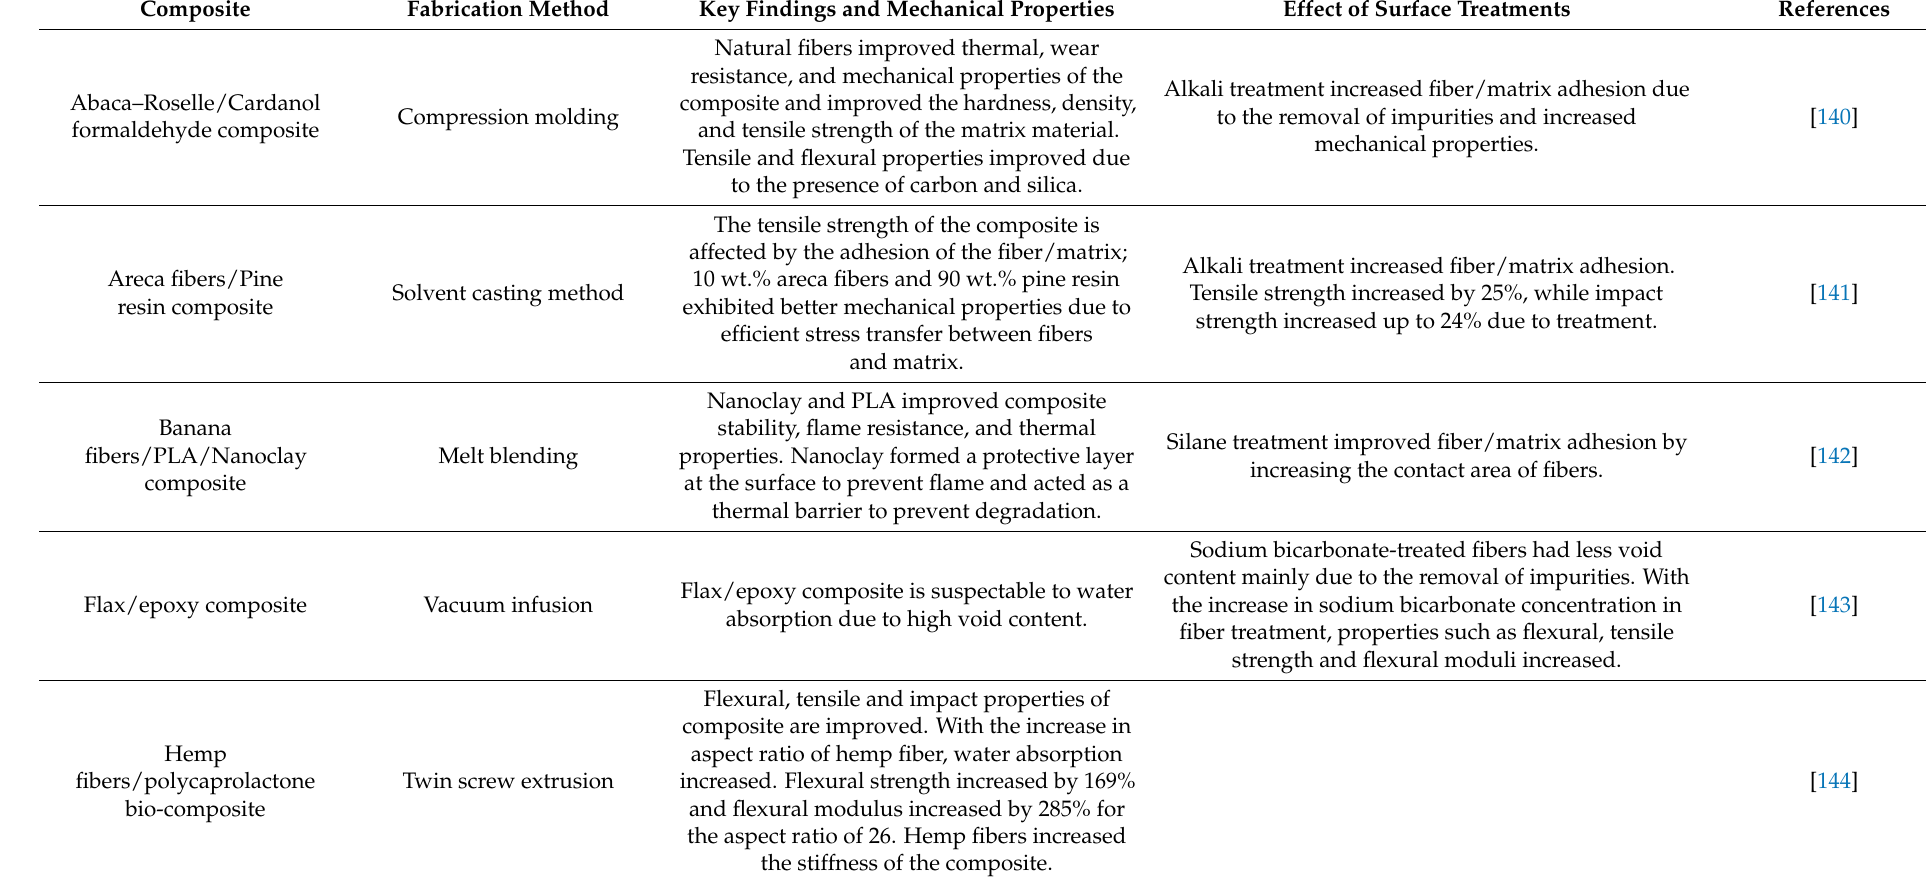
Table 2. Different research studies for bio-composites and modification